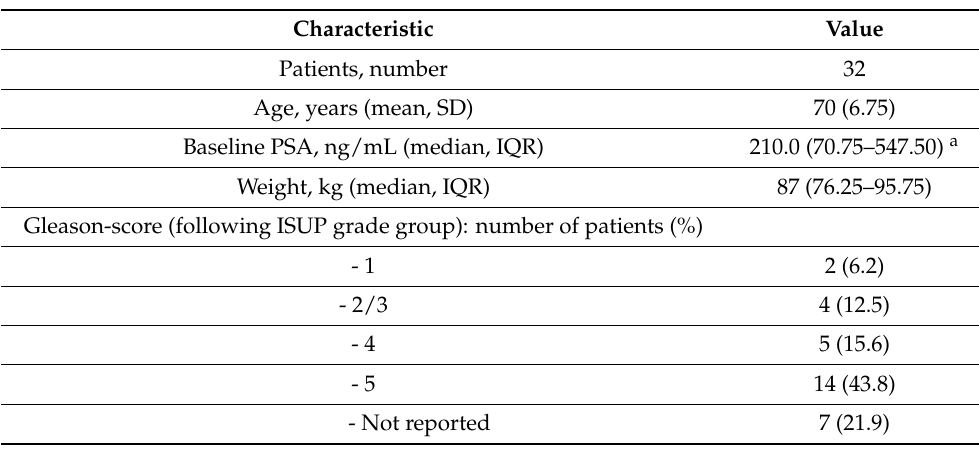
Table 1. Baseline patient